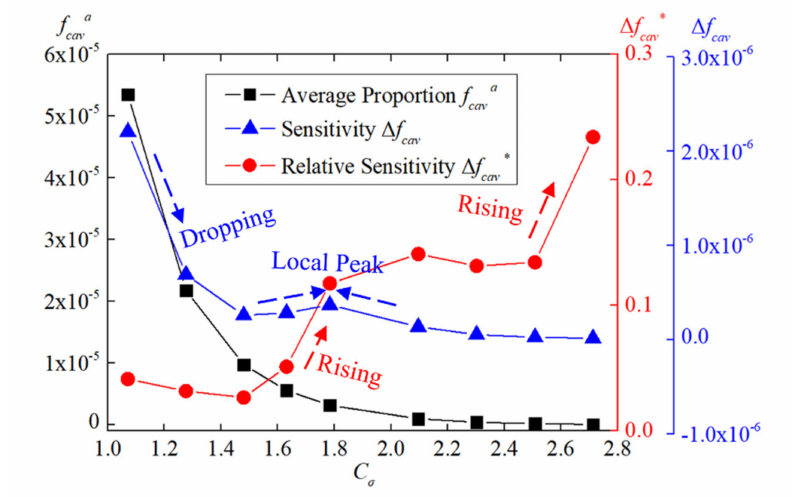
Figure 6. Sensitivity analysis of f cav at different C σ .